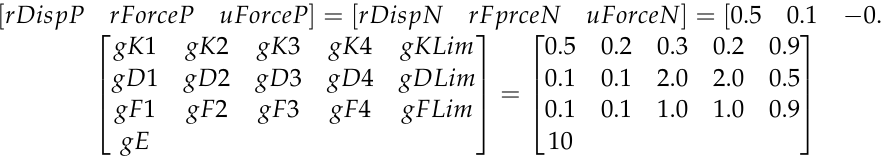
( b ) Figure 8. The IDA curves of the two structures: ( a ) 4-story; ( b ) 8-story.